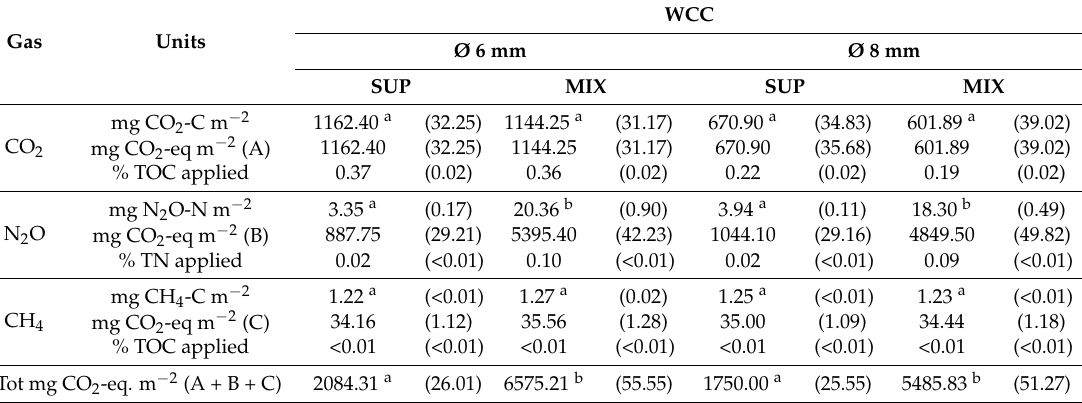
Table 4. Cumulative CO 2 , N 2 O and CH 4 emissions after 57-day experimental period related to WCC (Wood Chip Compost) pellet application. Mean value and standard error (in parentheses) of four replicates. Values with different letters are significantly different ( p < 0.05) within an individual